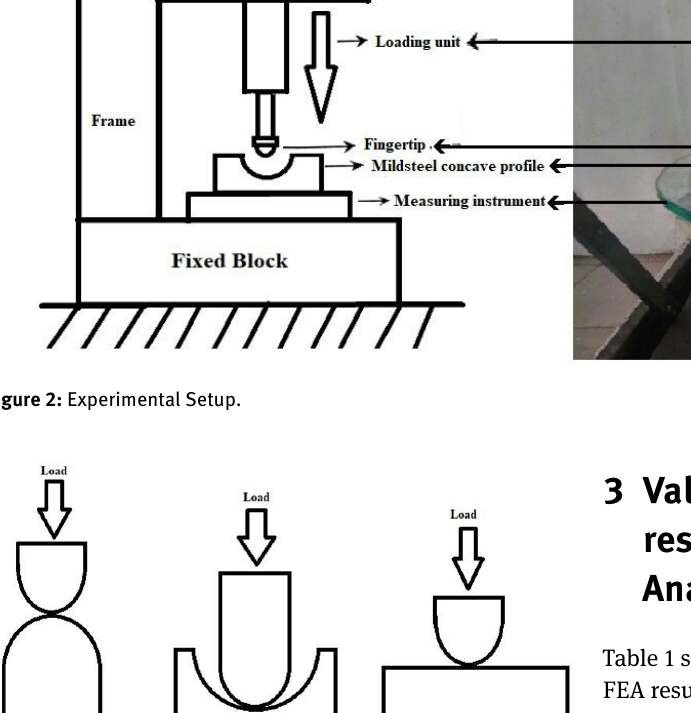
Figure 1: Fingertips with different radii.